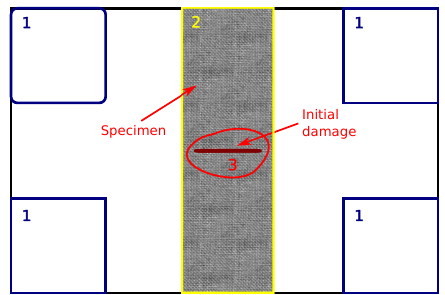
Figure 4. Distribution of ROIs in thermograph for segmentation and area calculation: 1) background tem- perature, 2) specimen temperature, 3) heated